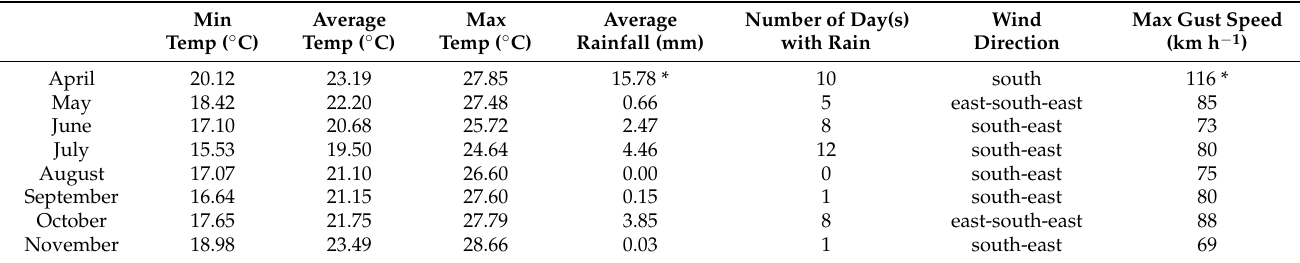
Table 1. Meteorological factors recorded from FIT (Flower Induction Treatment) in April 2018 to harvest in November 2018. Source of satellite image: https://www.geoportail.gouv.fr/ (accessed on 28 January